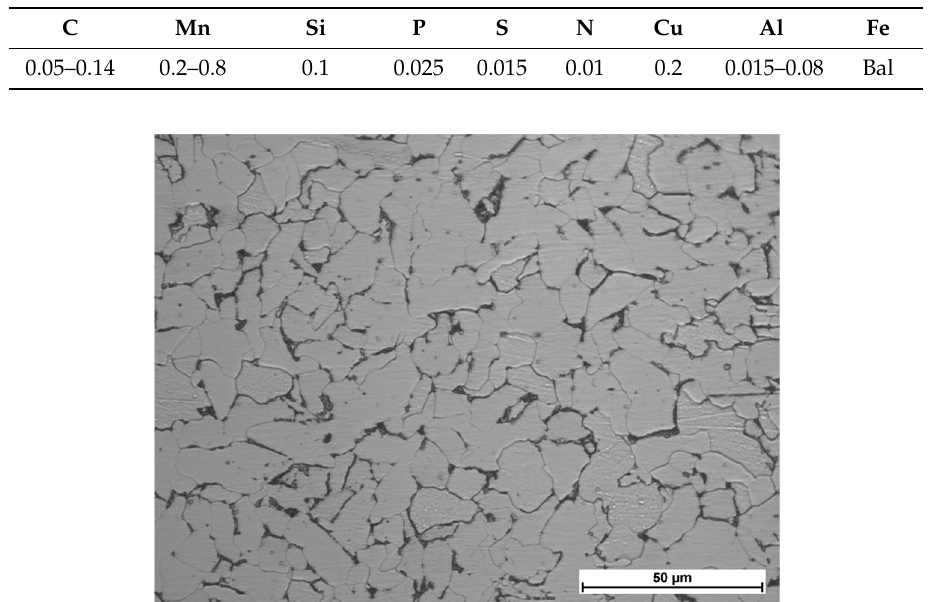
Table 1. Chemical composition of non-alloy structural steel S235JR (EN 10025-2) according to the Thyssenkrupp manufacturer’s data (wt. %), Figure 1.